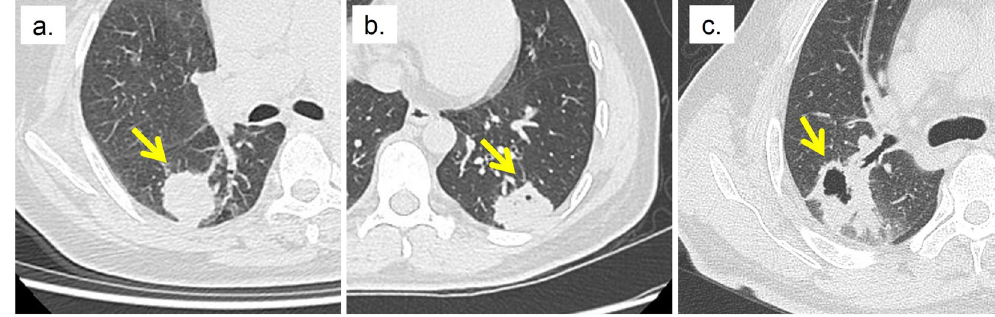
Figure 2. Tumors with and without cavitation. ( a ) Tumor without cavitation ( b ) Tumor with minor Cavitation ( c ) Tumor with major Cavitation. The arrow indicates the location of the tumor.